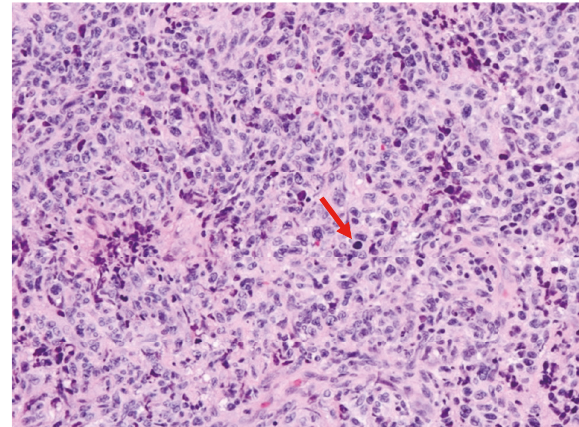
Figure 6: High power magnification,hematoxylinand eosin (H&E) staining. Sheets of dyscohesive atypical cells with large hyperchro- matic round nuclei and scant cytoplasm.